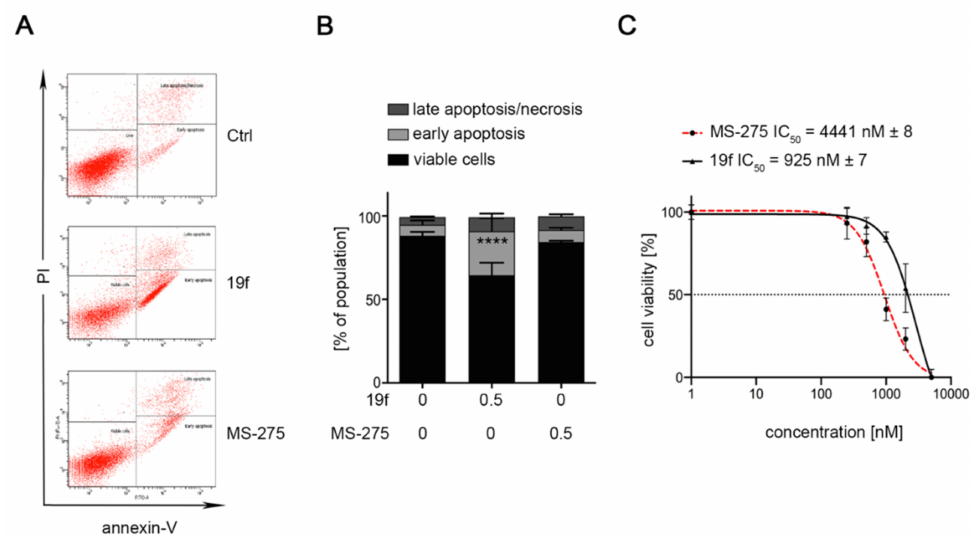
Figure 7. Cytotoxicity of MS-275 and 19f in leukemic HEL cells expressing JAK2V617F. ( A , B ) HEL cells were treated with 0.5 µ M of MS-275 or 19f for 48 h. ( B ) Cells were stained with annexin V-FITC/PI and analyzed via flow cytometry. Graphs show mean ± SD of three independent experiments (one-way ANOVA; two-way ANOVA; Bonferroni correction; **** p < 0.0001). ( C ) HEL cells were treated with increasing concentrations of MS-275 or 19f from 0.25 µ M to 5 µ M for 24 h. IC 50 values were determined for 19f. Results represent three independent